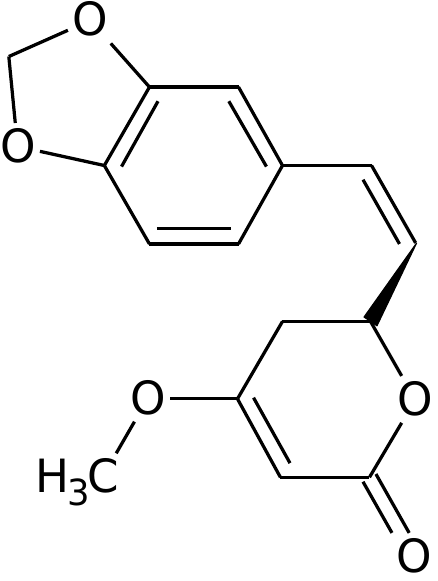
Figure 4. Chemical formula of methysticin.